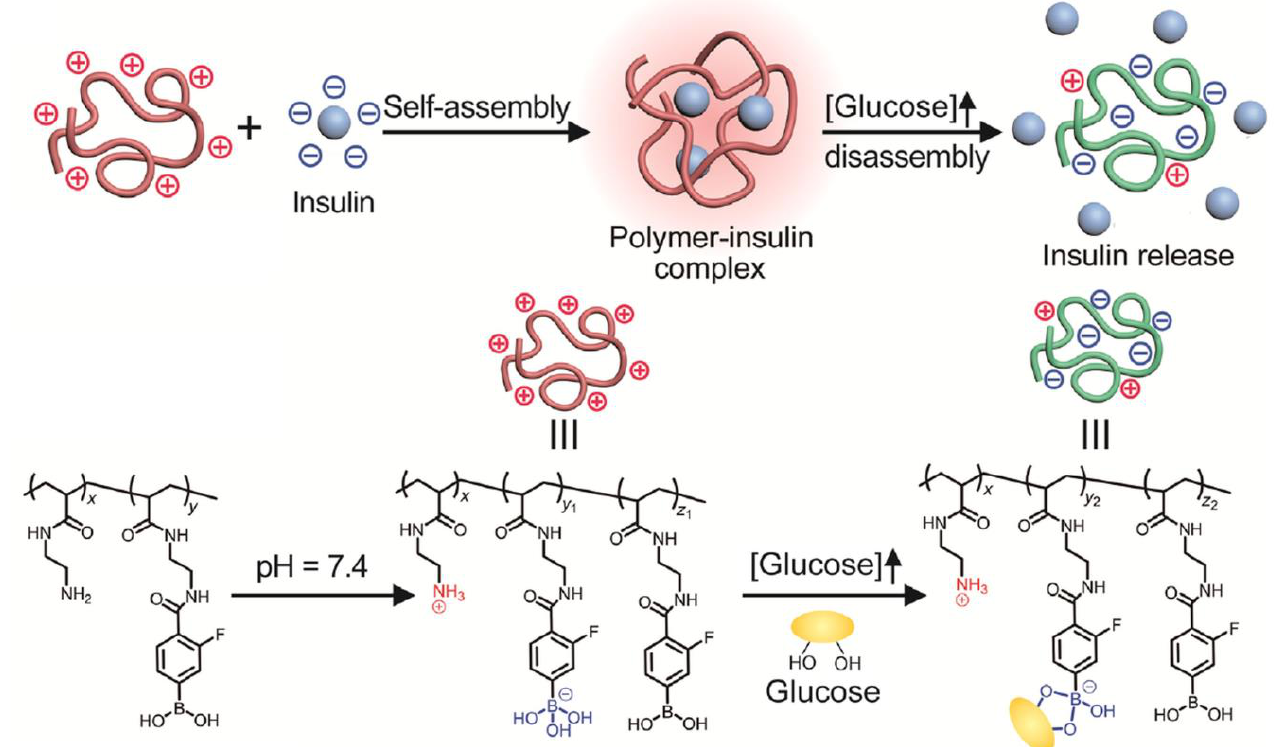
Figure 16. Schematic representation of polymer-insulin complex formation and of insulin release from complex under a hyperglycemic condition (Adapted from reference [104]. Copyright © 2023 by Wang, J. et al.).